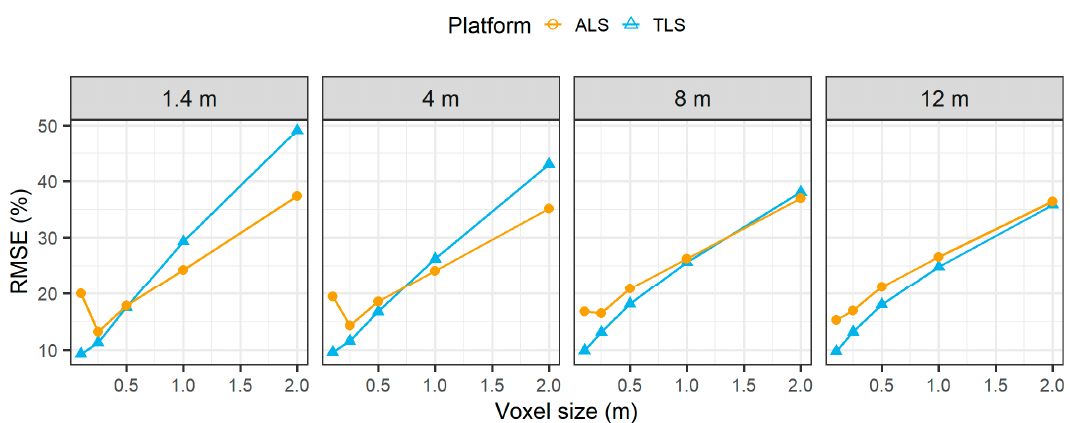
Figure 8. Root mean square error (RMSE) of the canopy gap estimates derived from airborne laser scanning (ALS) and terrestrial laser scanning (TLS) for each of the four height thresholds (m aboveground) and each voxel size. ALS and TLS-derived estimates were evaluated against reference values obtained from hemispherical photography.